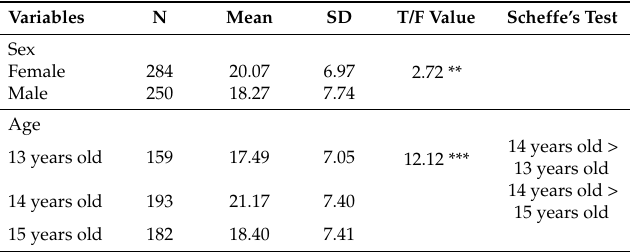
Table 5. Variations in knowledge of tobacco hazards prevention among the sex and age groups (n =